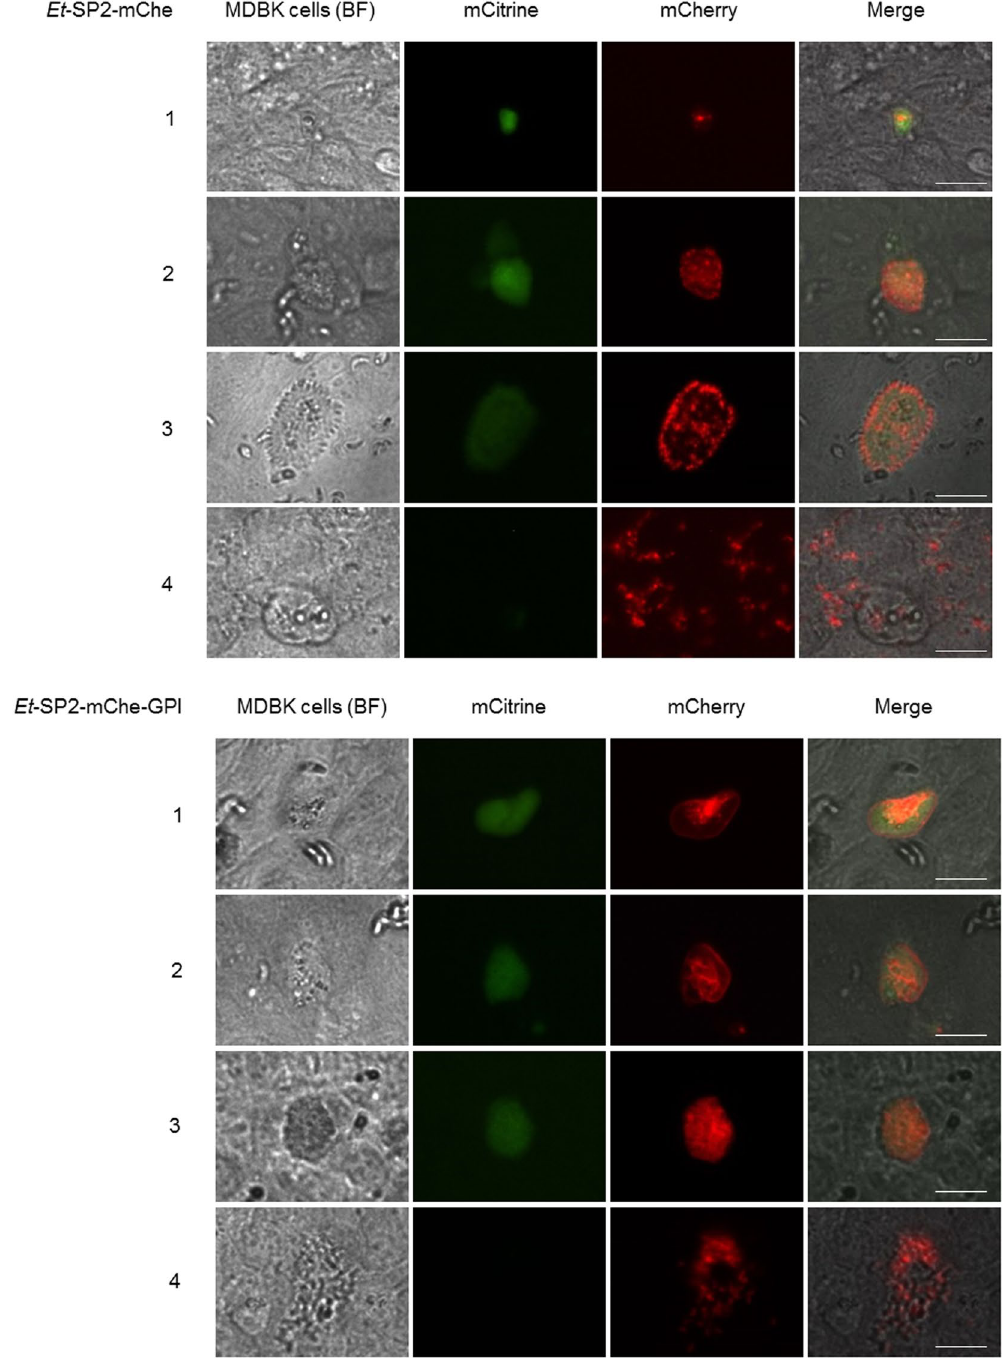
Figure 4. In vitro intracellular development of Et -SP2-mChe and Et -SP2-mChe-GPI after incubation in MDBK cells for 48 h (41 °C, 5% CO 2 ). Panels 1 and 2: schizont development; mCherry accumulated in vesicles in Et - SP2-mChe whereas it was membrane anchored in Et -SP2-mChe-GPI. Panels 3 and 4: first generation merozoite formation and release; mCherry was intracellular in the newly formed merozoites in Et -SP2-mChe, while appearing to be membrane anchored in nascent merozoites in Et -SP2-mChe-GPI. mCitrine almost completely vanished in both populations. BF = bright field. Bars represent 20 µ